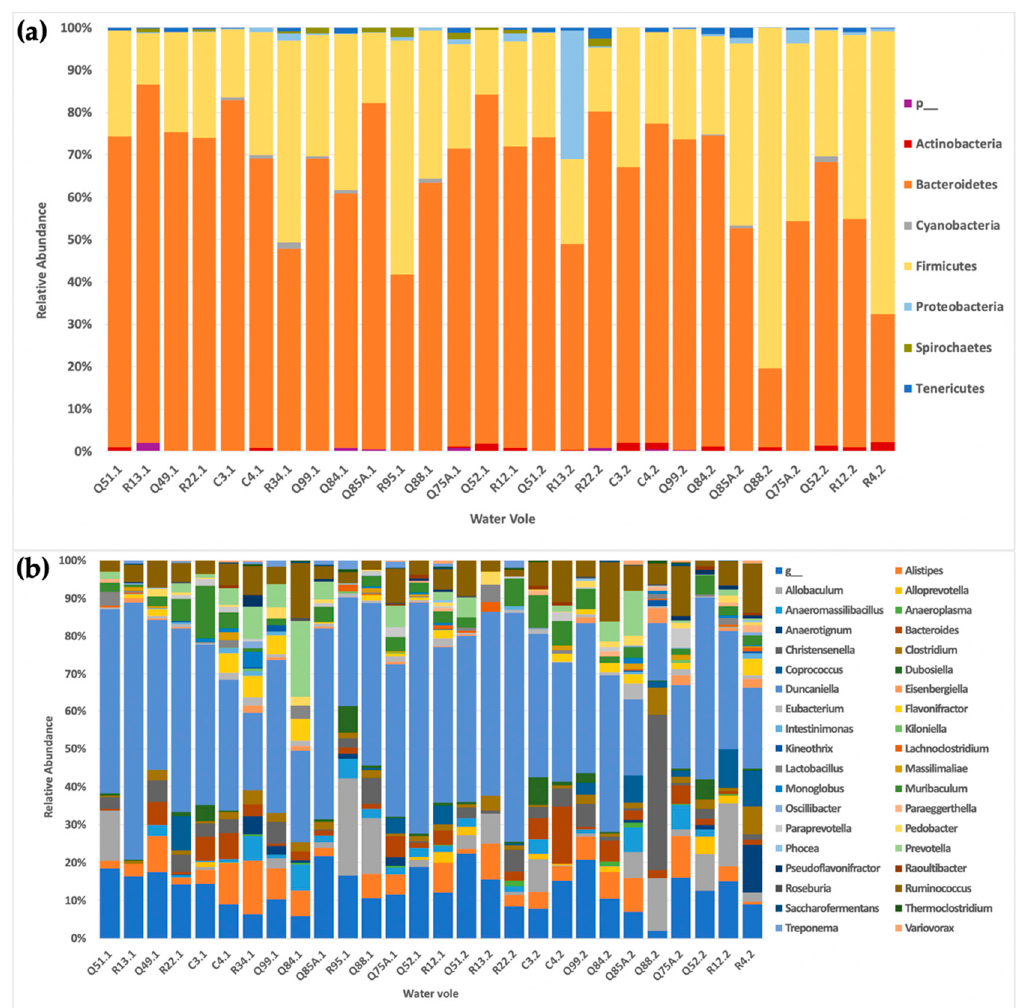
Figure 1. Relative abundance of OTUs across the sample population. ( a ) Relative taxa abundance of the sampled water voles at the phylum level. Across the majority of voles, Bacteroidetes (orange) dominate. These are followed by the Firmicutes (yellow), which collectively account for over 90% of the out abundance at the phylum level. R13.1 shows a significant increase in Proteobacteria (light blue). “p-” signifies all mergoutOTU phylum data that have a relative abundance that is below 1% across samples. ( b ) Relative taxa abundance of the sampled water voles at the genus level. Across the majority of voles, the relative abundance of OTUs at the genus level is consistent. One notable observed difference is the relative increase in Christensenella (dark grey) in Q88.1. “g-” signifies all merged OTU genus data that have a relative abundance that is below 1% across samples.